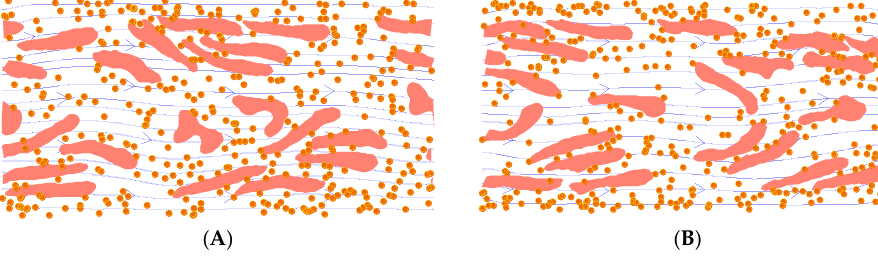
Figure 5. Snapshots from a channel flow simulation for a cell-particle mixture with a hematocrit level of 23.5% and a shear rate of 200 s − 1 at 0.26 s ( A ) and 0.46 s ( B ). Fluid streamlines are shown in the background, while the yellow markers represent 100-nm nanoparticles. For illustration purposes, cells and particles are not shown to scale. A short movie of the simulation is provided in the Supplementary Materials.